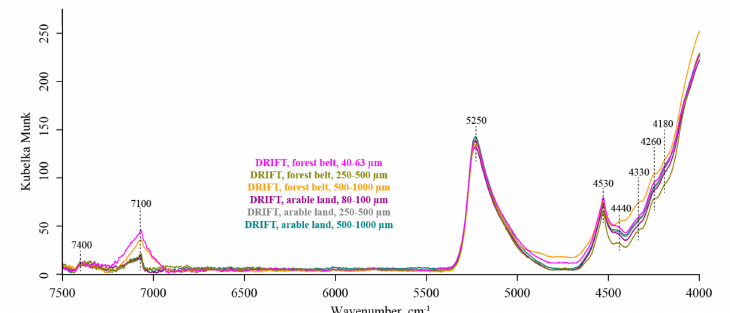
Figure 4. Normalized and scattering baseline-corrected DRIFT FTIR spectra in the region 7500–4500 cm − 1 of chernozem soil (dry fractionation): forest belt, fractions, 40–63 µ m, light magenta, 250–500 µ m, khaki, and 500–1000 µ m, orange; arable land, 80–100 µ m, dark magenta, 250–500 µ m, gray, and 500–1000 µ m, dark cyan.